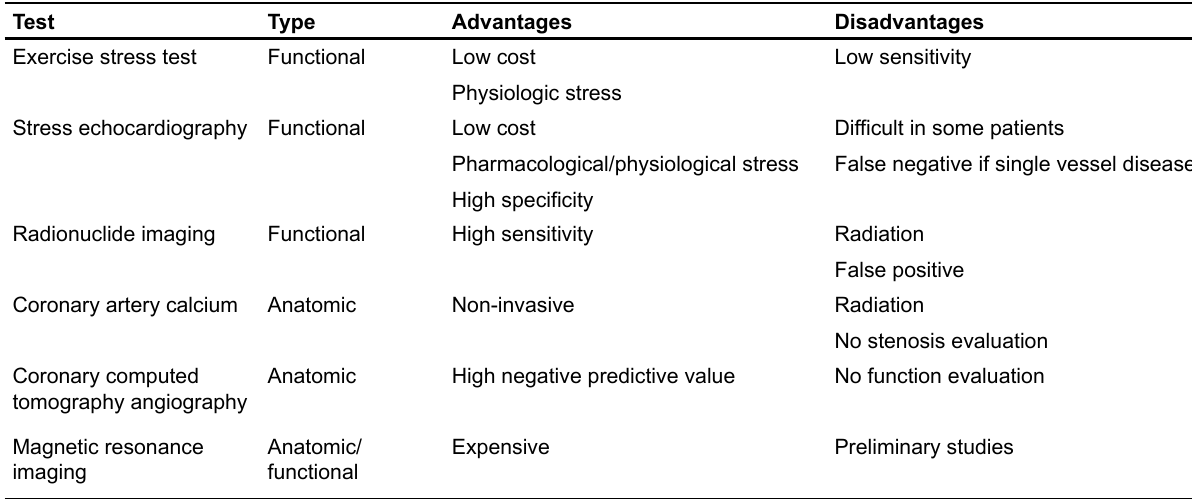
Low sensitivity Difficult in some patients False negative if single vessel disease False positive No stenosis evaluation